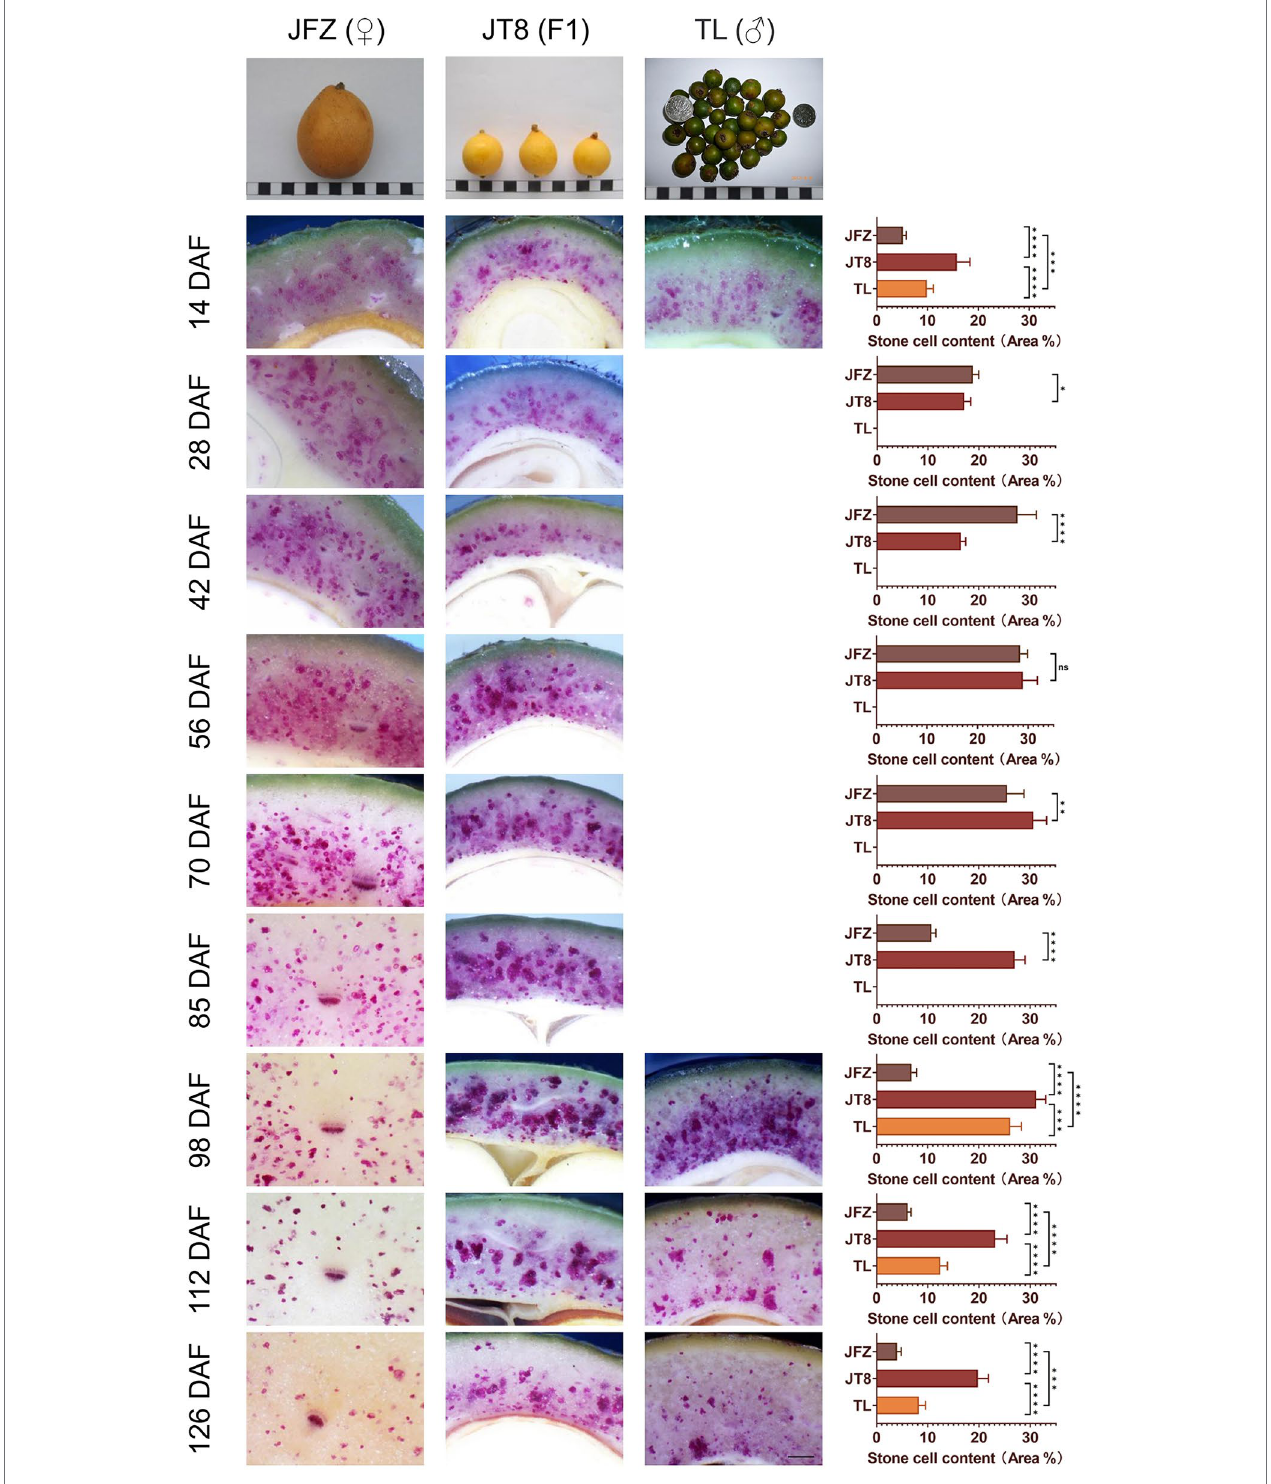
FIGURE 2 | Phloroglucinol-HCl staining and microscopic observation of transverse sections of fruit pulp from three loquat plants. Due to the few samples in wild loquat TL, only four developmental stages were examined, including 14, 98, 112, and 126 DAF. Three fruit images at the top of the figure show the mature fruit size, shape, and color of three loquat plants; in particular, the color of mature TL fruits was brown green. The width of each black or white box represents 1 cm; the black bar at lower right represents 500 μ m; bar charts show the stone cell density; and “ns” represents that there is no significant difference, “*” represents value of p < 0.05, “**” represents value of p < 0.01, “***” represents value of p < 0.001, and “****” represents value of p <